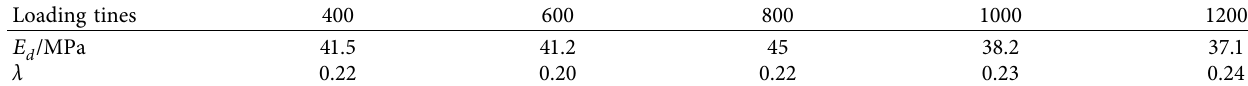
Table 3: The dynamic modulus and damping ratio.